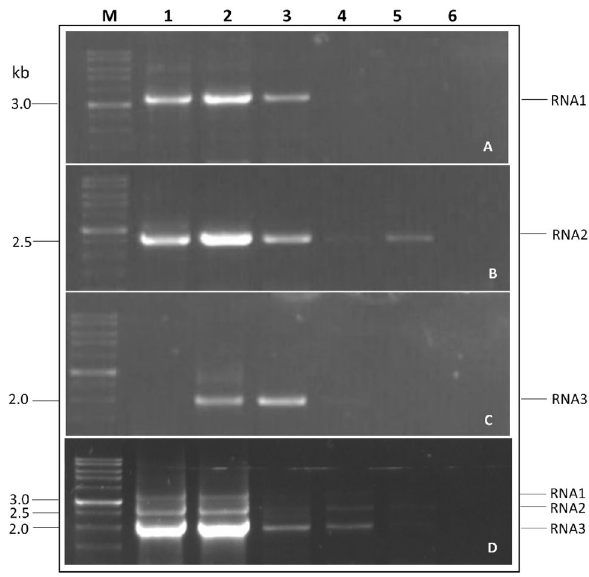
Figure 2. Sensitivity of one-step RT and mRT-PCR for all three fragments of PNRSV using tenfold serial dilutions of RNA. Lanes 1–6: 10 0 (400 ng)-10 –5 (0.004 ng) serial dilutions. Lane M: 1 kb DNA ladder (RTU, GeneDireX, Taiwan).